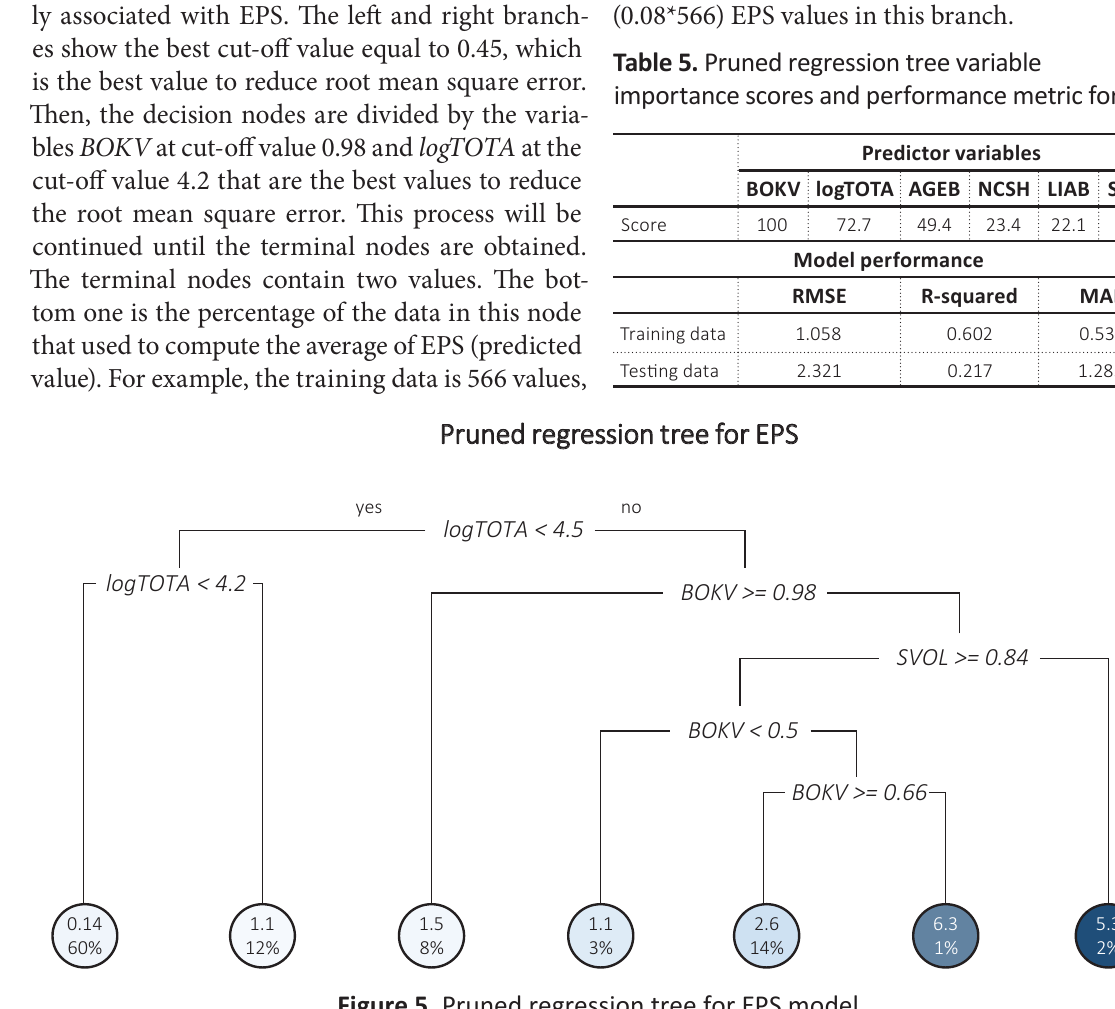
Figure 5. Pruned regression tree for EPS model